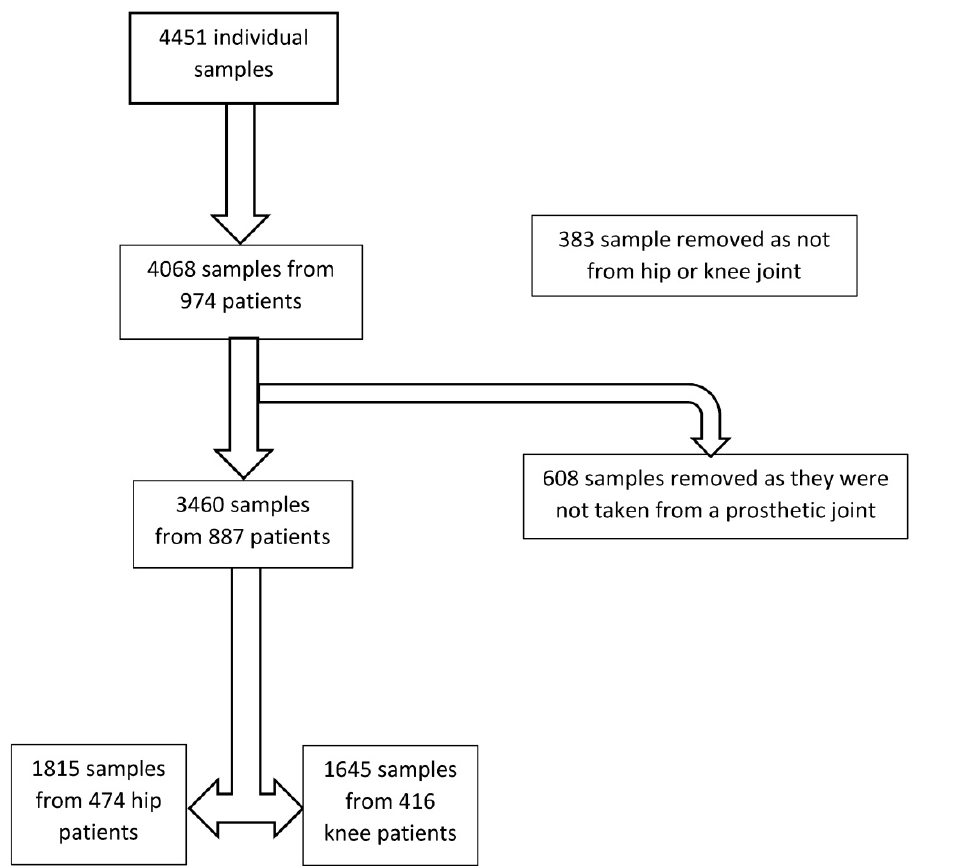
Figure 1: Flow chart showing development of final patient cohort from initial data